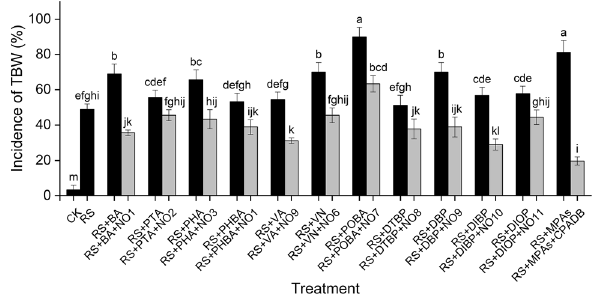
Figure 5. The incidence of TBW of various treatments. RS, R. solanacearum 1–1, MPAs, mixed phenolic allelochemicals; CPADB, combined phenolic allelochemicals-degrading bacteria; RS + BA, the CK group supplemented with R. solanacearum 1–1 and BA in the soil; RS + BA + NO1, the group of “RS + BA” adding Bacillus sp. NO1 in the soil. The same as below. All treatment groups were compared with the CK group for significant difference